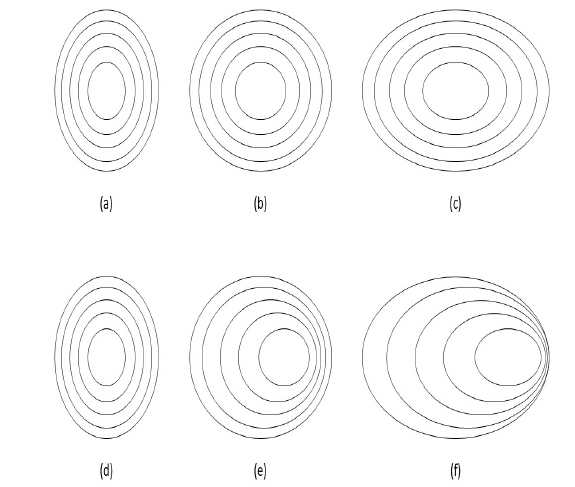
Figure 1. A schematic representation of a chemical tracer in a porous media illustrating ( a ) the injection of tracer, ( b ) the reaction between the injected tracer and the injected water bank, ( c ) the extraction stage without the influence of drift and ( d – f ) shows the same process of tracer injec- tion/extraction process displayed in ( a – c ), however, drift effect fully revealed during the extraction stage in ( f